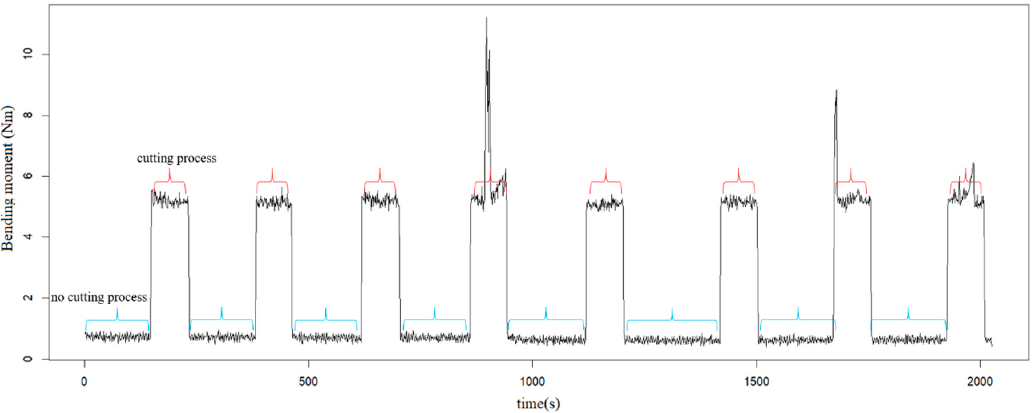
Figure 3. The bending moment signals.